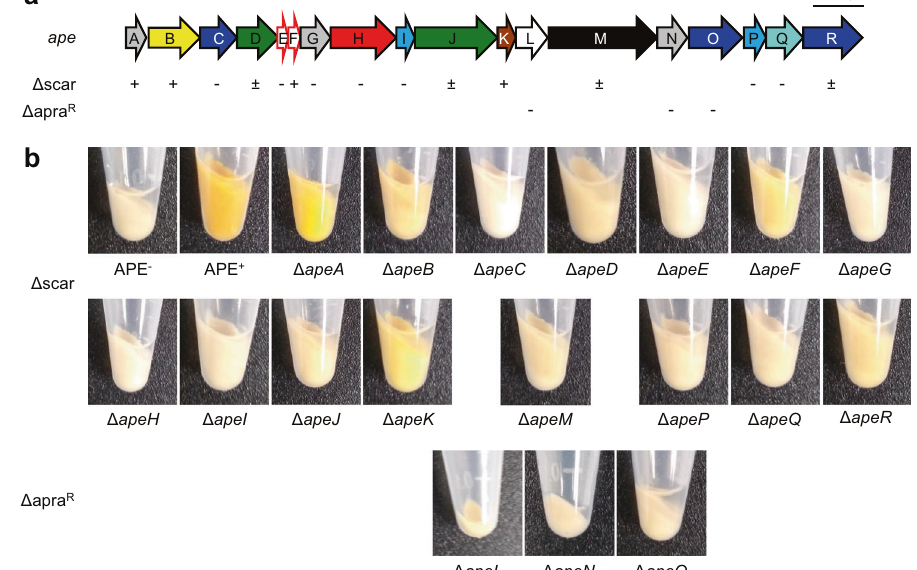
Fig. 2 Pigmentation phenotype of individual deletion mutants in the APE Ec BGC. a Schematic arrow representation of the E. coli CFT073 APE Ec BGC (see Table 1 for predicted gene functions). The pigmentation phenotype of individual scarred deletion mutants ( Δ scar) is reported below the BGC as follows: + (near wild-type level pigmentation), ± (largely reduced pigmentation), – (nonpigmented). We did not obtain scarred deletion mutants for apaL , apeN, and ape O, and their respective Δ apra R mutants are not pigmented. b Pigmentation phenotypes of the cell pellets from individual Δ ape strains in comparison to cell pellet pigmentation from APE − and APE + cultures. The cell pellet extracts (reconstituted in MeOH) of these strains are depicted in Fig.